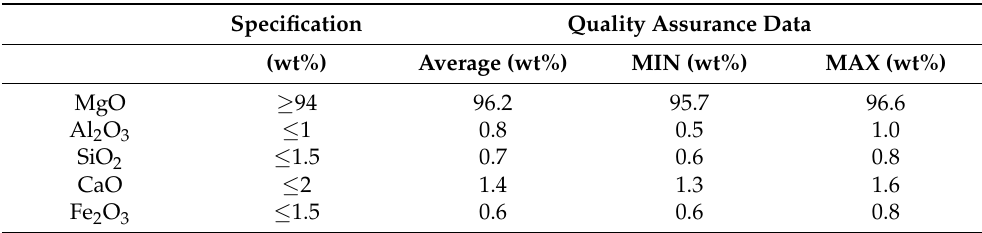
Table 1. Chemical composition of the recyclate R94A1 (0–6 mm) according to the manufacturer’s specification and data of the quality assurance over a period of 12 months (as of November 2022)